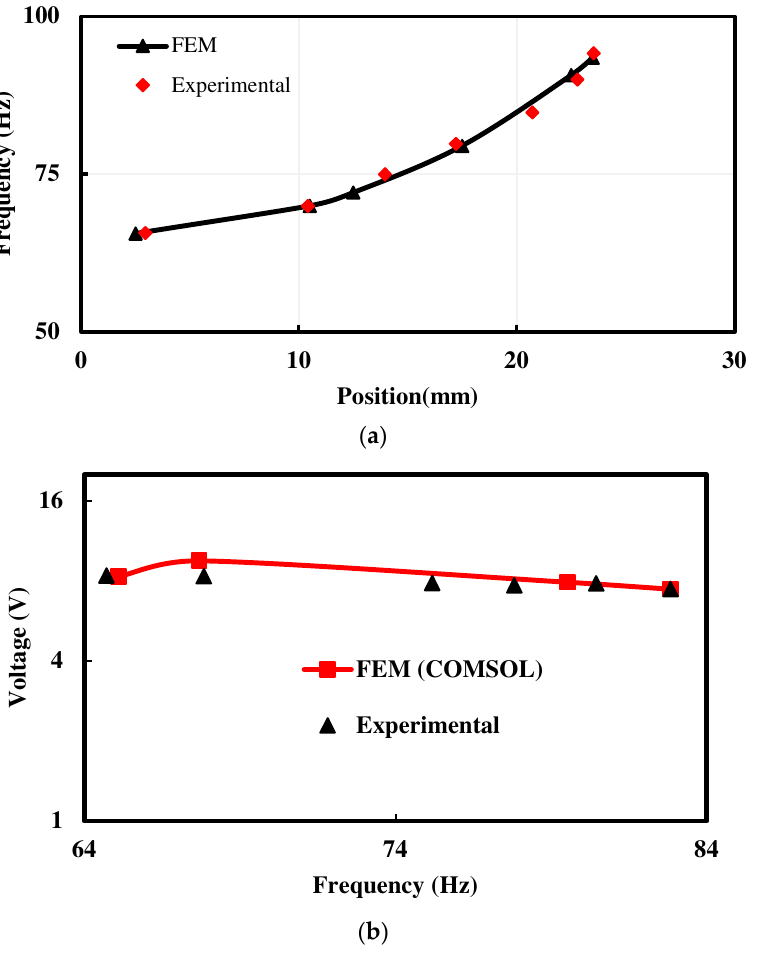
Figure 4. Comparison of the FEM COMSOL model results and the experimental results of refer- ence [43]. ( a ) frequency position relation, ( b ) voltage frequency relation.